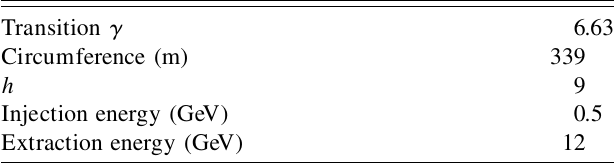
TABLE II. Machine parameters for the KEK-PS.